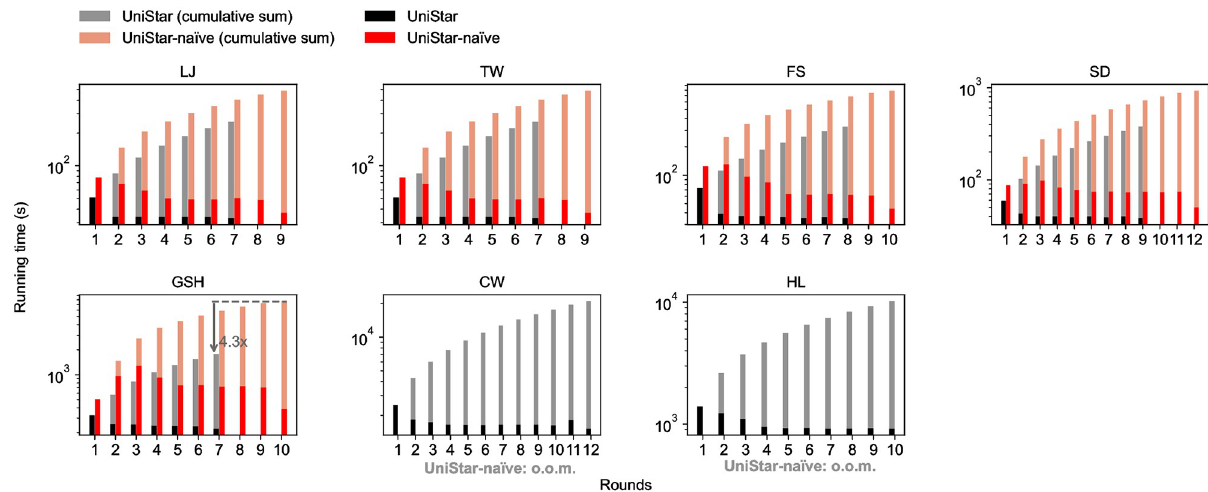
Fig 9. The running time of UniStar and UniStar-na ï ve, and its’ cumulative sums, respectively. UniStar is faster than UniStar-na ï ve in all rounds and requires fewer rounds.